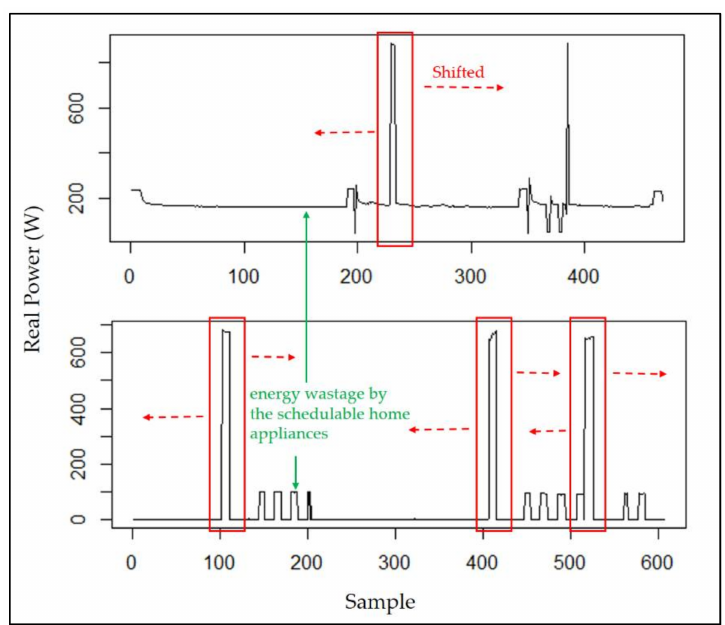
Figure 2. Load profile of electric water boilers.